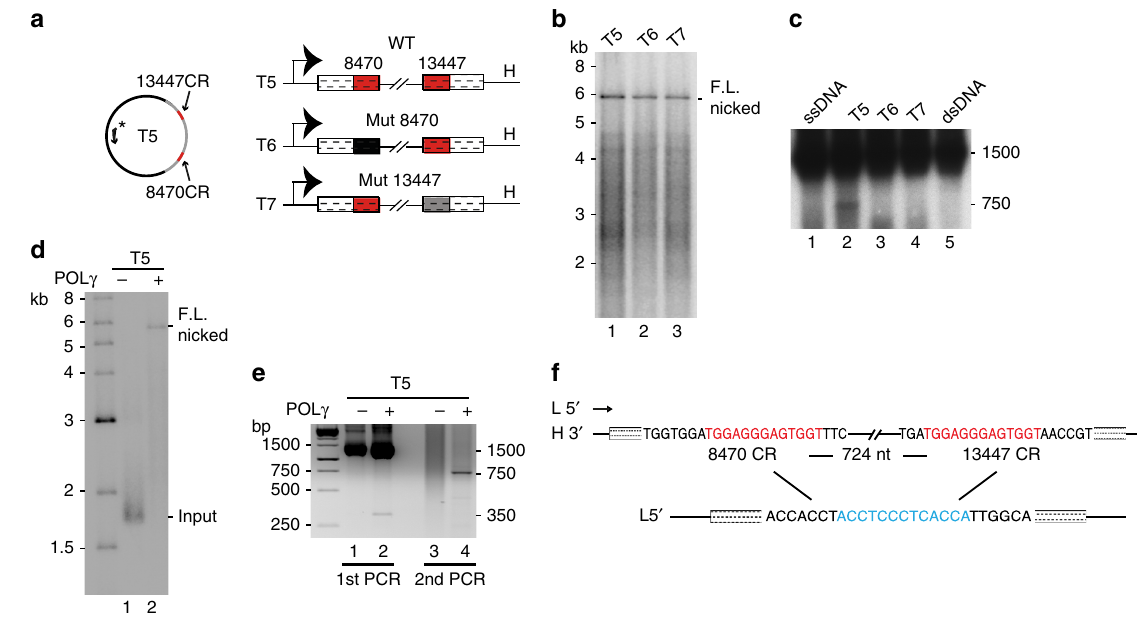
Fig. 4 Common deletion formation during L-strand synthesis. a The wild-type template used is identical to that in Fig. 2a, but without the arti fi cial replication barrier (T5). Mutant versions were created in which 8470-CR (T6) and 13447-CR (T7) had been mutated. For details see Supplementary Table 1. b L-strand DNA synthesis of the templates described in panel a . c The reactions in panel b were analysed by PCR followed by Southern blotting. The T5 template substrate was included in lane 1. Lane 5: double-stranded DNA control. d L-strand DNA synthesis as in panel b using the T5 template. e The reactions in panel d were analysed by PCR. After a fi rst round of PCR (1st PCR) the products in the region around 750 bp were gel puri fi ed, followed by a second round of PCR (2nd PCR). f The vast majority (98%) of the 750-bp products corresponded to the common deletion. For details see Supplementary Table 2. Source data are provided as a Source Data fi